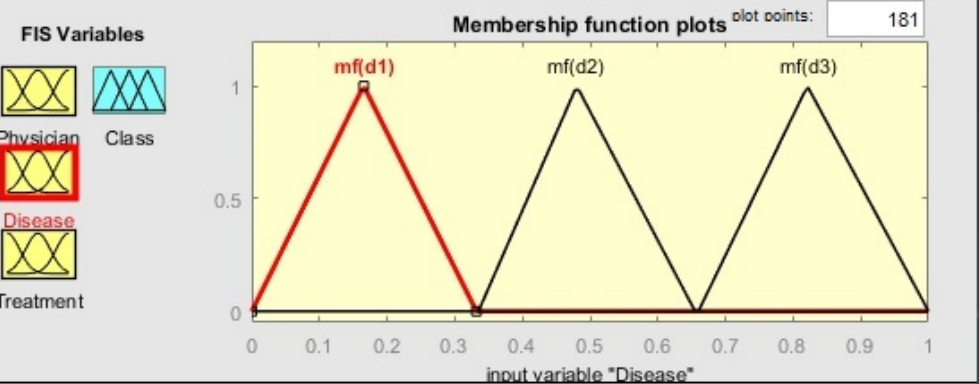
Figure 1. Matlab simulation of membership